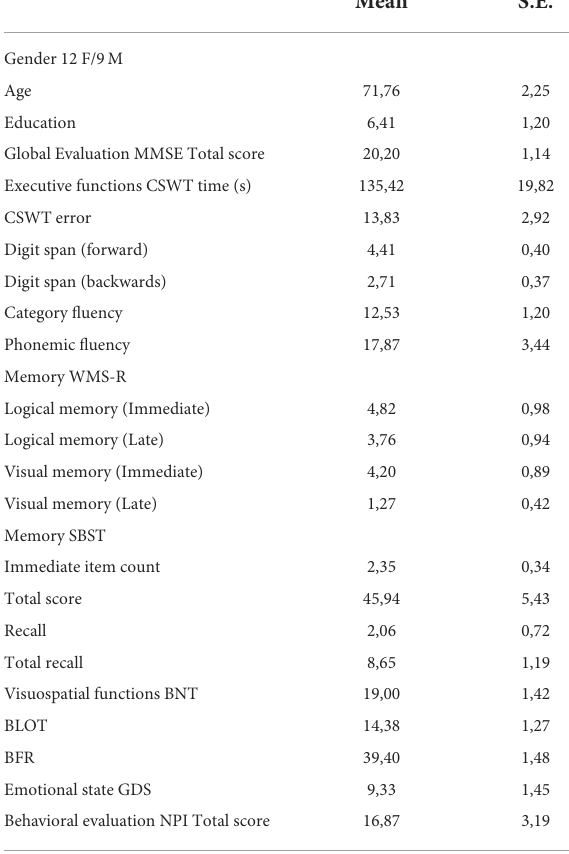
TABLE 1 The demographical and neuropsychological test scores of the patient group with Alzheimer’s disease (AD). Mean S.E.